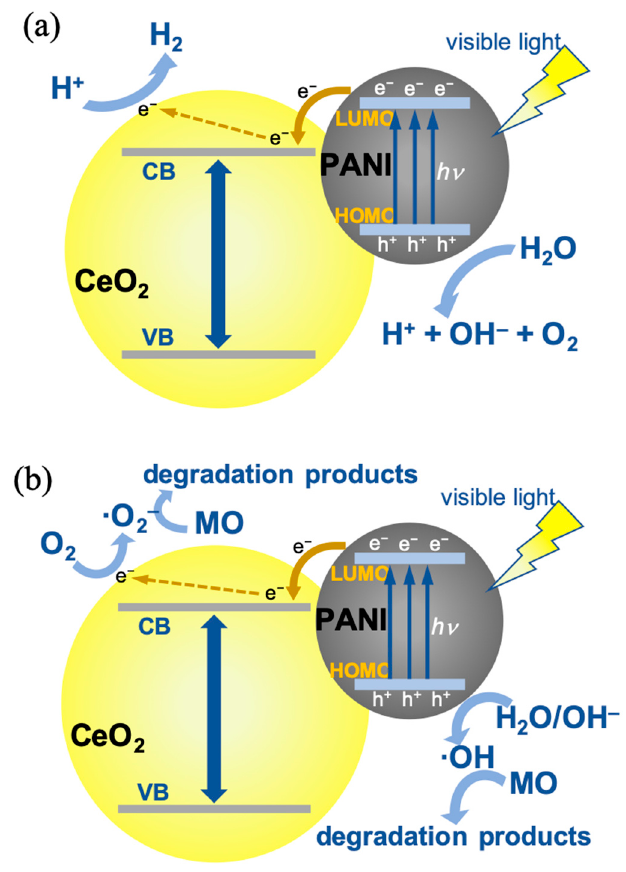
Figure 12. Schematic diagram of ( a ) hydrogen production and ( b ) MO degradation mechanisms of the heterostructured CeO 2 /PANI powders under visible light irradiation.